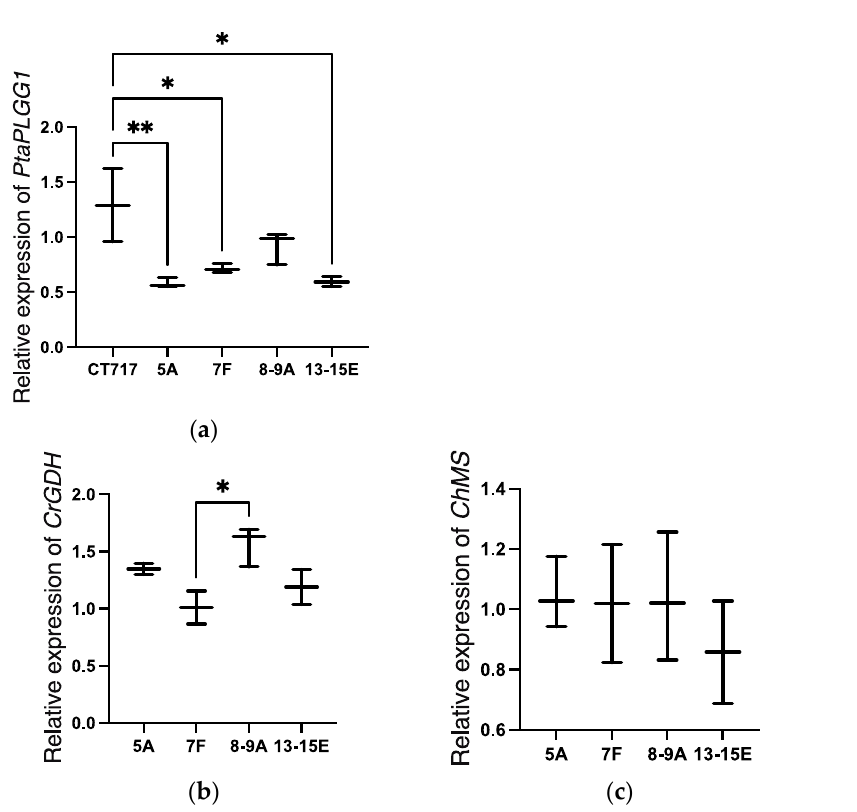
Figure 3. Transgene expression analysis in selected C1 transgenic events. ( a ) Expression analysis of PtaPLGG1 in transgenic plants in the C1 experiment. Tissue samples were collected from Leaf 3 with three ramets per event except for two for Event 13-15E at Week 14. Reference gene used in this multiplex assay: PtaAct . ( b , c ) Expression analysis of CrGDH ( b ) and ChMS ( c ) in transgenic plants in the C1 experiment. Tissue samples were collected from Leaf 3 at Week 14. Statistical signi fi cance: p ≤ 0.05 (*), p ≤ 0.01 (**).